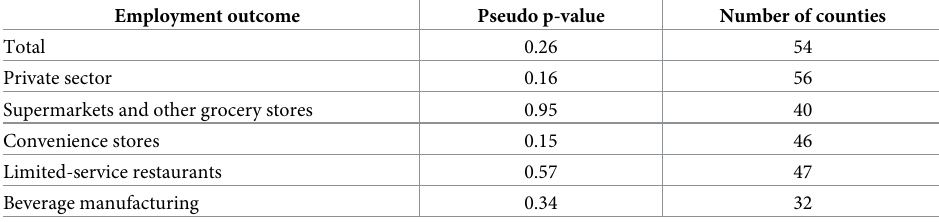
Table 3. Pseudo p-values and number of counties used in the placebo test for each employment outcome.